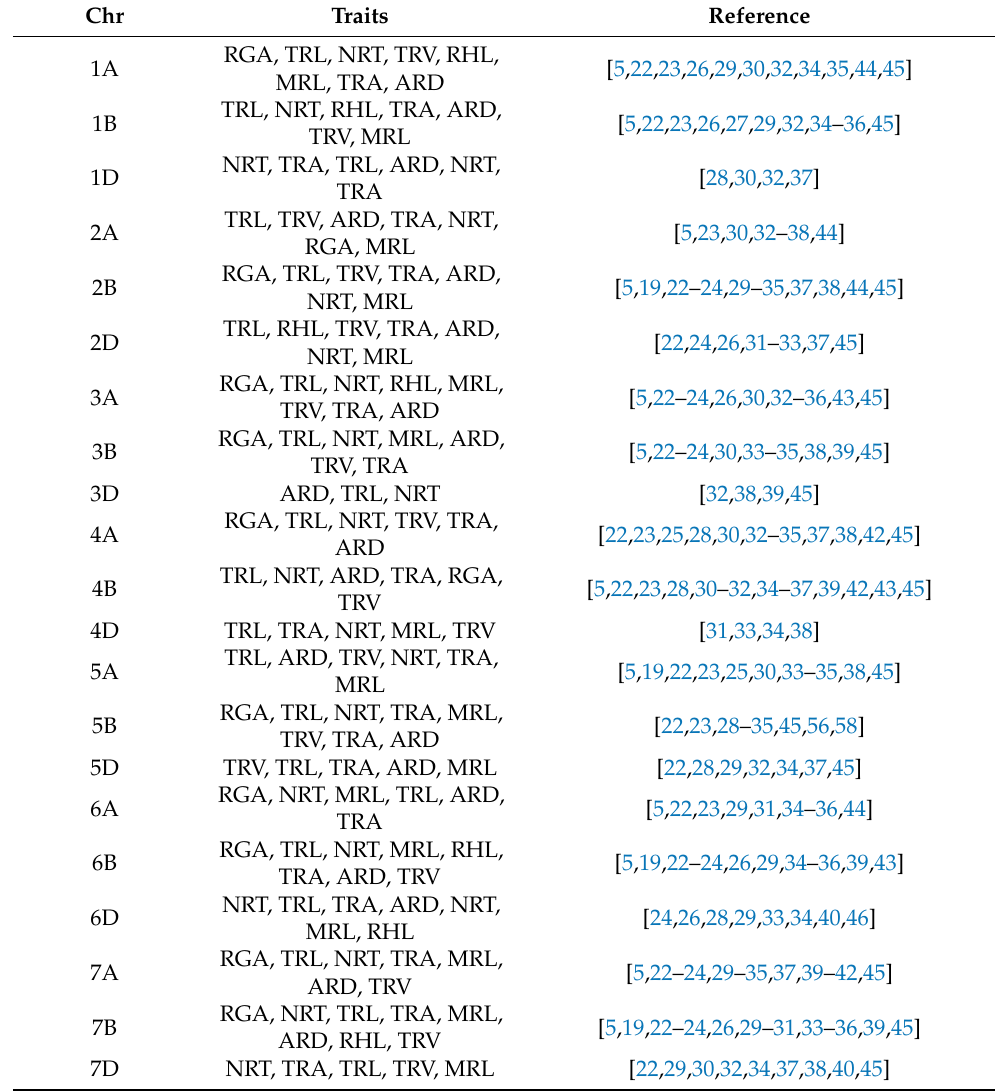
Table 5. Published studies on RSA traits and their chromosome localisations. Chr Traits